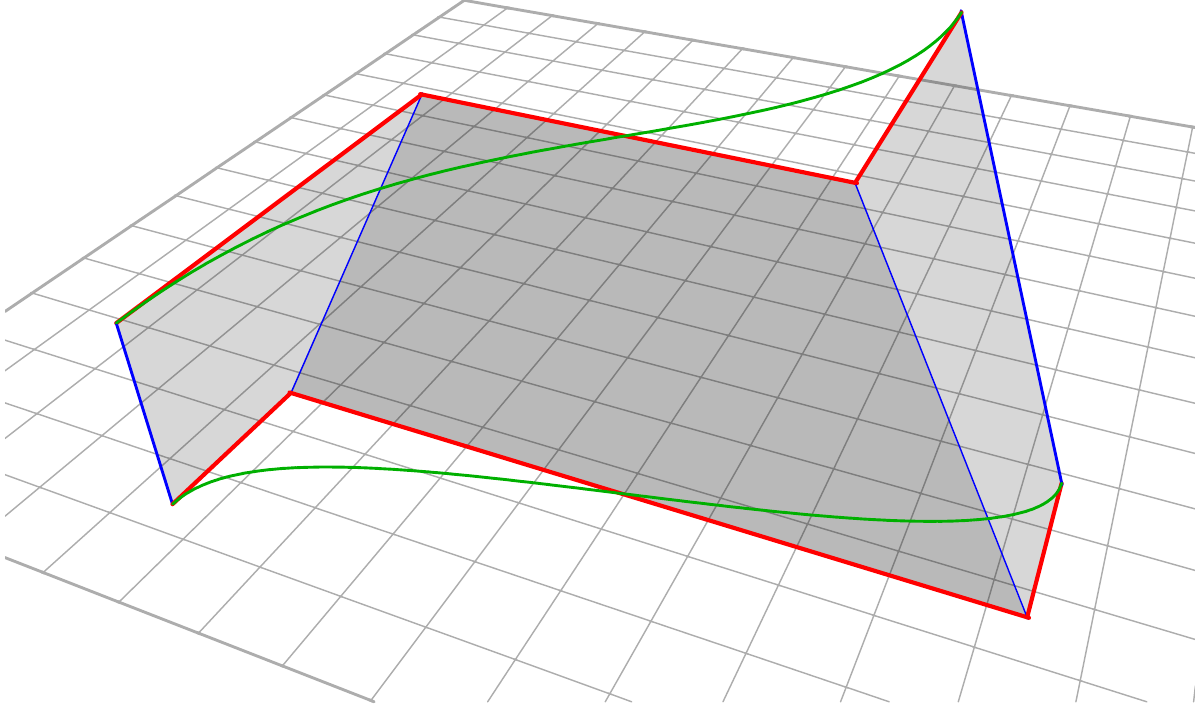
Figure 1. Two ‘S’ shaped splines constructed using edges of three connected planar quadrilaterals. Note that the two splines are not in the same plane and indeed that they need not even be planar.